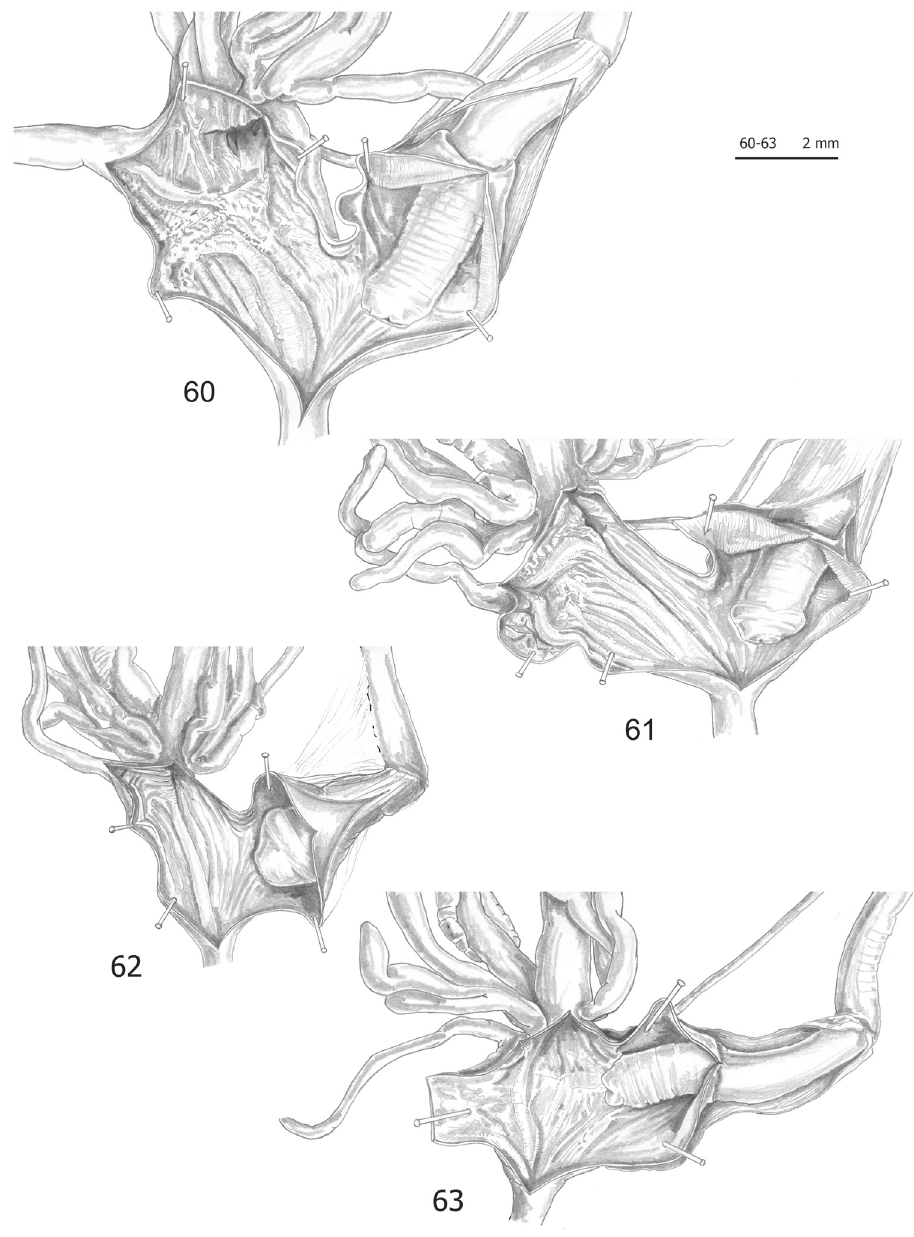
Figures 60–63. Internal structure of distal genitalia of Monacha pantanellii from Valle dell’Aniene, Roc- cagiovine [Ani] (FGC 42974) ( 60 ), Via Salaria, Ornaro Alto [Alt] (FGC 41553) ( 61 ), Turania [Tur1] (FGC 42971) ( 62 ) and road to Montenero Sabino [Sab] (FGC 41552) ( 63